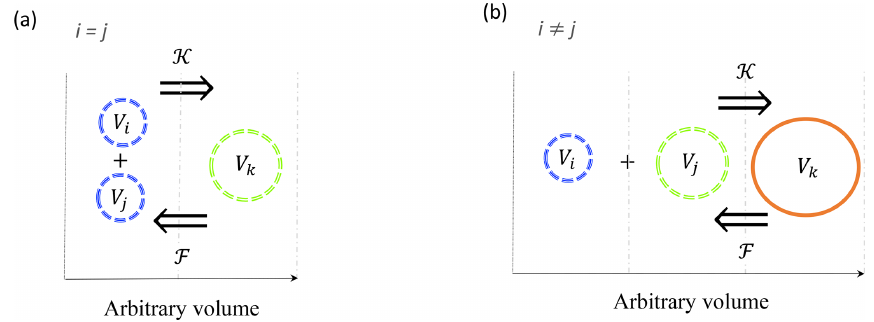
Figure 1. Schematic representation of coagulation K and fragmentation F reactions between triplets of particles in a linear size discretization. Coagulation is the process by which two particles with indices i and j collide and stick together to form a third, larger one with index k . Fragmentation is the opposite process by which a particle k breaks into two smaller ones i and j . Size bounds are shown by vertical dashed grey lines. Reactions involving two small particles (a) from the same size bin ( i = j ) and (b) from two different size bins ( i (cid:54)= j ) are